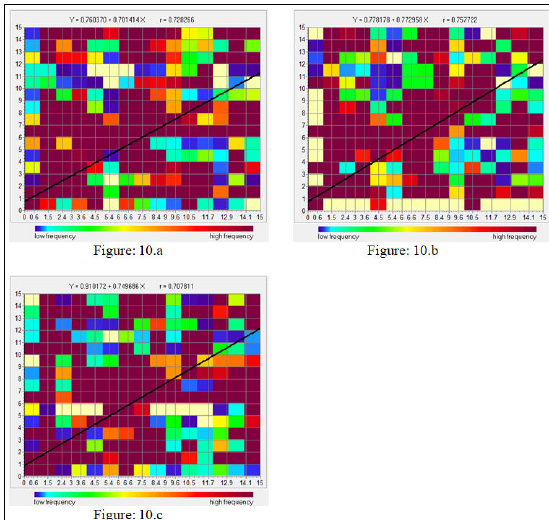
Figure 10.a. Relationships between predicted LULC of 2017 using 1987 & 1997 LULC image and predicted LULC of 2017 using 1997 & 2007 LULC image; Figure 10.b. Relationships between predicted LULC of 2017 using 1997 & 2007 LULC